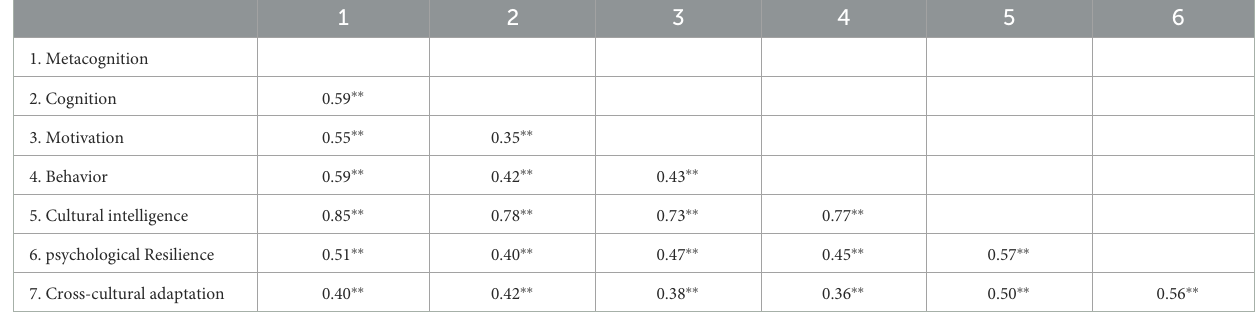
TABLE 3 Correlation analysis between cultural intelligence, psychological resilience, and cross-cultural adaptation.